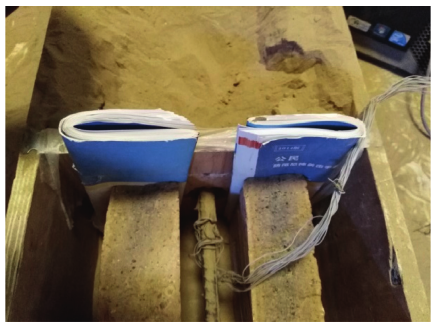
Figure 6: Preparation for model test.